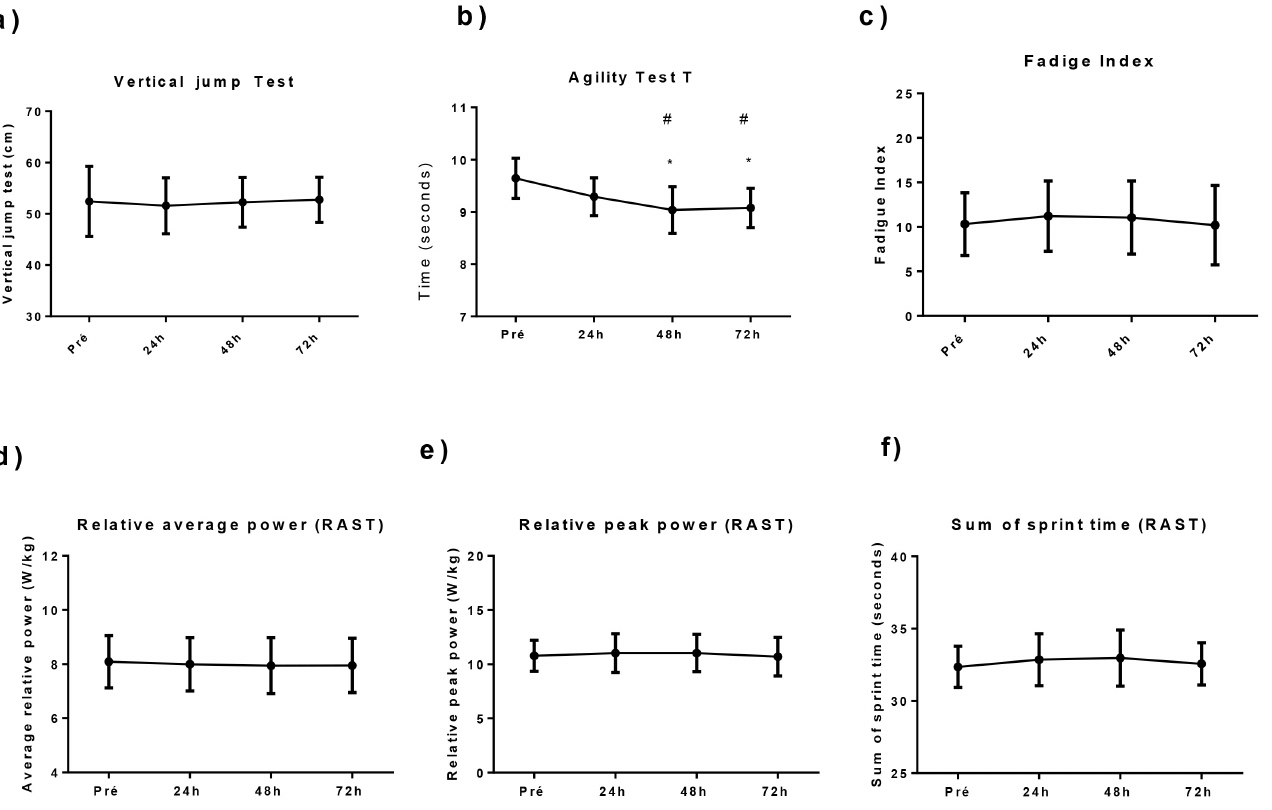
Figure 2. Vertical jump height (a) Agility test T (b), in RAST test fatigue index (c), relative average power (d), relative peak power (e) and sum of sprint time (f). The data are presented in mean ± SD. N = 19. * Difference from pre, # difference from 24h. P